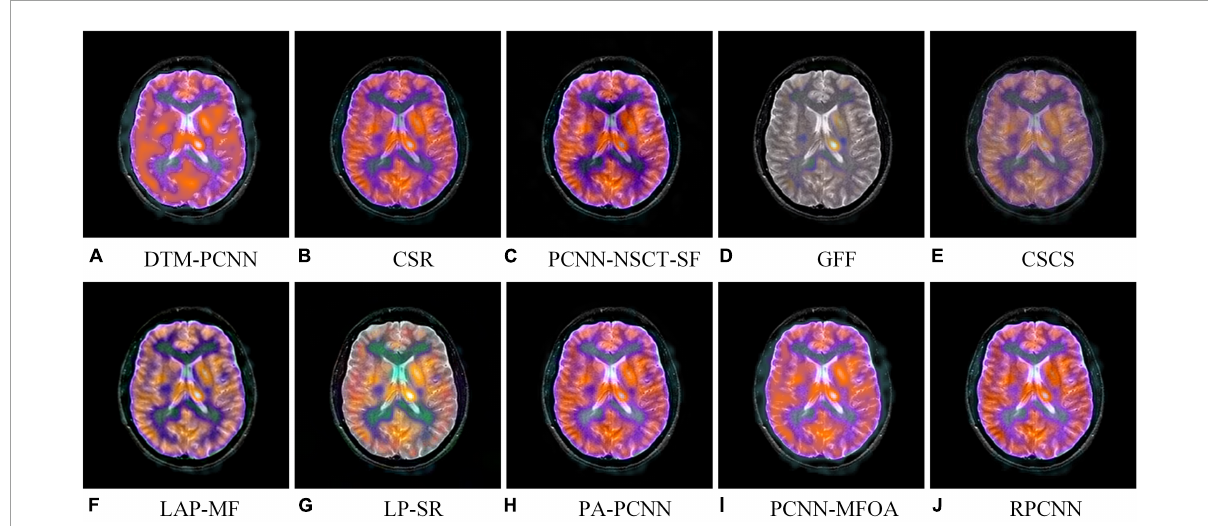
FIGURE3 An example of fused images generated by ten different MMIF algorithms. Algorithms include (A) discrete Tchebichef moments and pulse coupled neural network (DTM-PCNN) (Min et al., 2019), (B) convolutional sparse representation (CSR) (Liu et al., 2016), (C) pulse-coupled neural network with modified spatial frequency based on non-subsampled contourlet transform (PCNN-NSCT-SF) (Das and Kundu, 2012), (D) guided filtering (GFF) (Li et al., 2013), (E) cross-scale coefficient selection (CSCS) (Shen et al., 2013), (F) union Laplacian pyramid with multiple features (LAP-MF) (Du et al., 2016b), (G) Laplacian pyramid and sparse representation (LP-SR) (Liu et al., 2015), (H) parameter-adaptive pulse-coupled neural network (PA-PCNN) (Yin et al., 2019), (I) pulse coupled neural network using the multi-swarm fruit fly optimization algorithm (PCNN-MFOA) (Tang et al., 2019), and (J) reduced pulse-coupled neural network (RPCNN) (Das and Kundu, 2013).